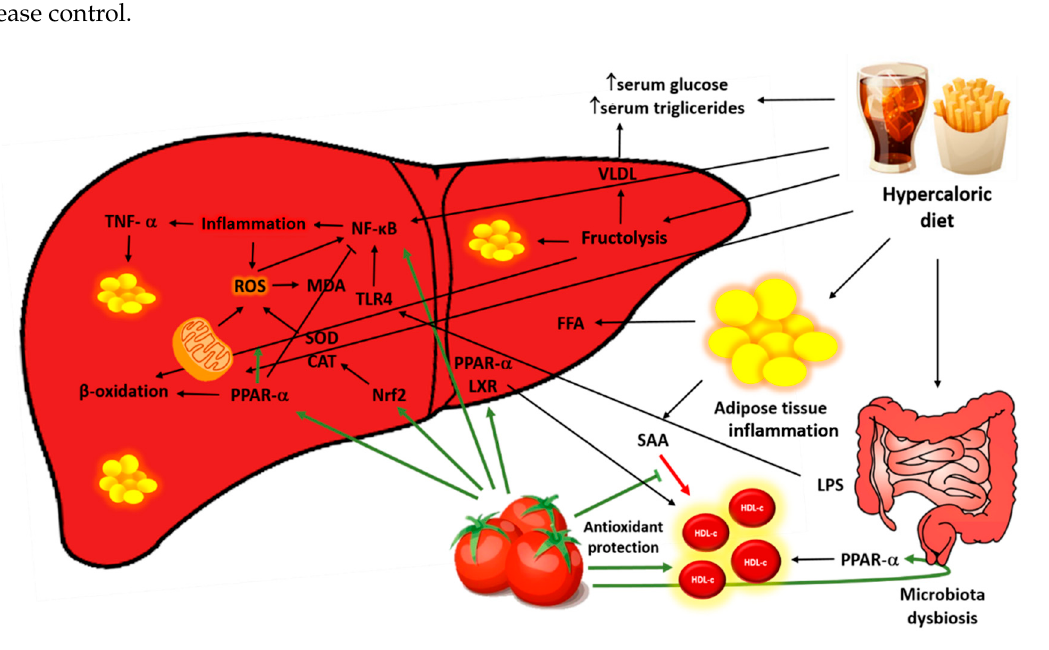
Figure 7. Role of lycopene in the pathophysiological process of non-alcoholic fatty liver disease (NAFLD). The hypercaloric diet provides large amounts of fat and especially sugars, which saturate the liver’s ability to export triglycerides leading to its accumulation in the hepatocyte in addition to increased levels of triglyceride and plasma glucose. These macronutrients also activate inflammatory pathways directly by NF- κ B activation and indirectly through alteration of intestinal permeability and translocation of LPS to the liver. The excess nutrients overload the oxidation capacity of mitochondria leading to ROS production, establishing a mutually dependent process between inflammation and oxidative stress. Lycopene was efficient in controlling the inflammatory and oxidative pathways, as well as in the antioxidant activity and assisted in the control of the accumulation of hepatic lipids, activating β -oxidation. Furthermore, the carotenoid improved blood lipids profile by lowering triglycerides and increasing HDL-C levels. LPS: Lipopolysaccharides; SAA: Serum amyloid A; HDL-c: High-density lipoprotein cholesterol; VLDL: Very low-density lipoprotein, FFA: Free fatty acid; Nrf2: Nuclear factor erythroid 2–related factor 2; PPAR- α : Peroxisome proliferator-activated receptor α ; SOD: Superoxide dismutase CAT: Catalase; TLR4: Toll-like receptor 4; ROS: Reactive oxygen species; MDA: Malondialdehyde; TNF- α : Tumor necrosis factor- α .